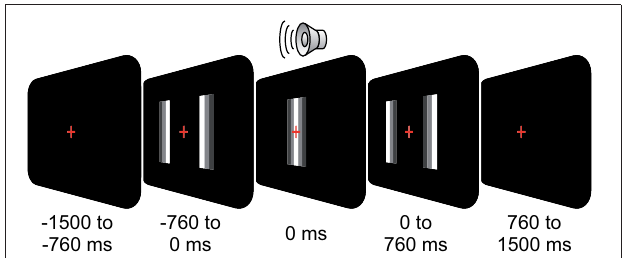
FIGURE 1 | Behavioral task. On each trial, subjects fixated a central cross while two moving bars approached each other, overlapped, and diverged again (total duration, 1.52s). At the moment of overlap ( t = 0s), a click-sound was played (duration, 0.02s). The stimulus was either perceived as two bars passing each other (pass) or bouncing off each other (bounce). Subjects reported their percept via button-press (left/right thumb) after fixation cross offset (0.76s after stimulus